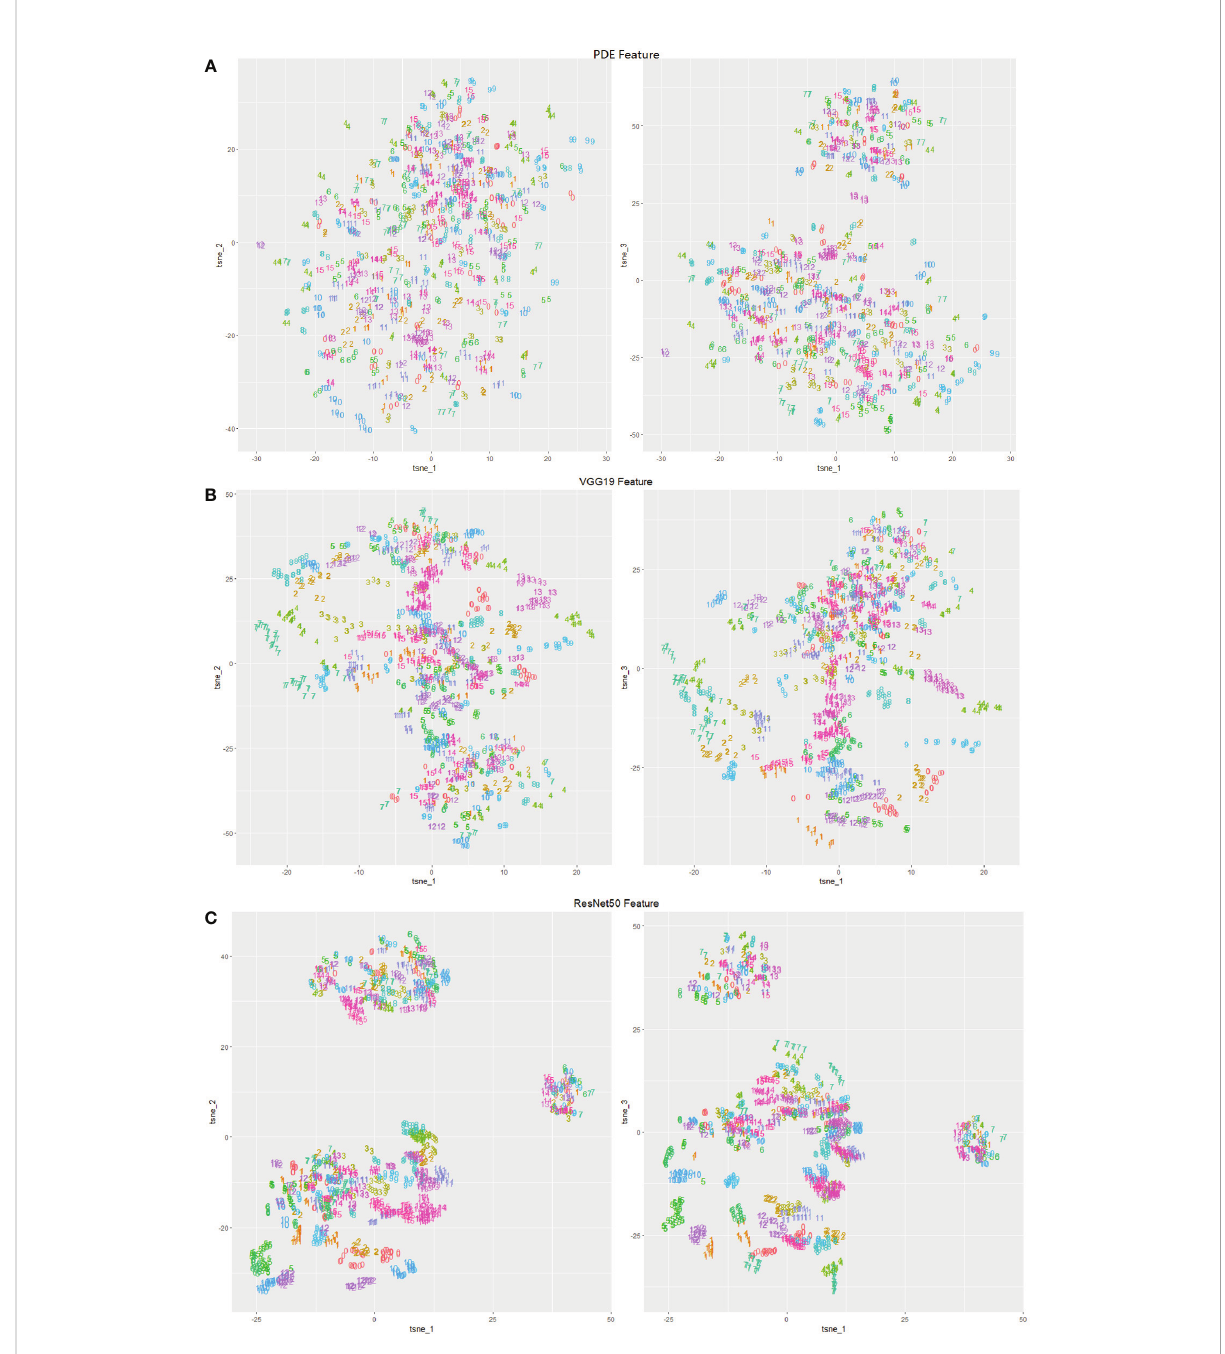
FIGURE 3 Visualization of feature-extraction methods (number labels in the range of 1~20 denote 20 individuals randomly sampled from all the P. leopardus ) (A) PDE feature; (B) CNN ResNet50 feature; (C) CNN VGG19